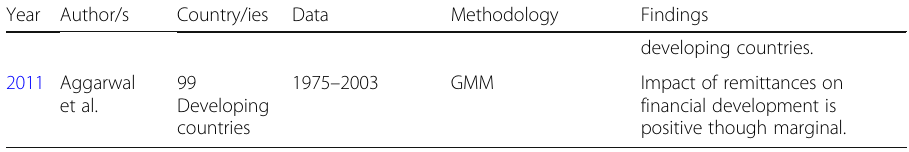
Table 1 Summary of International Empirical Evidence on remittances-financial development relationship